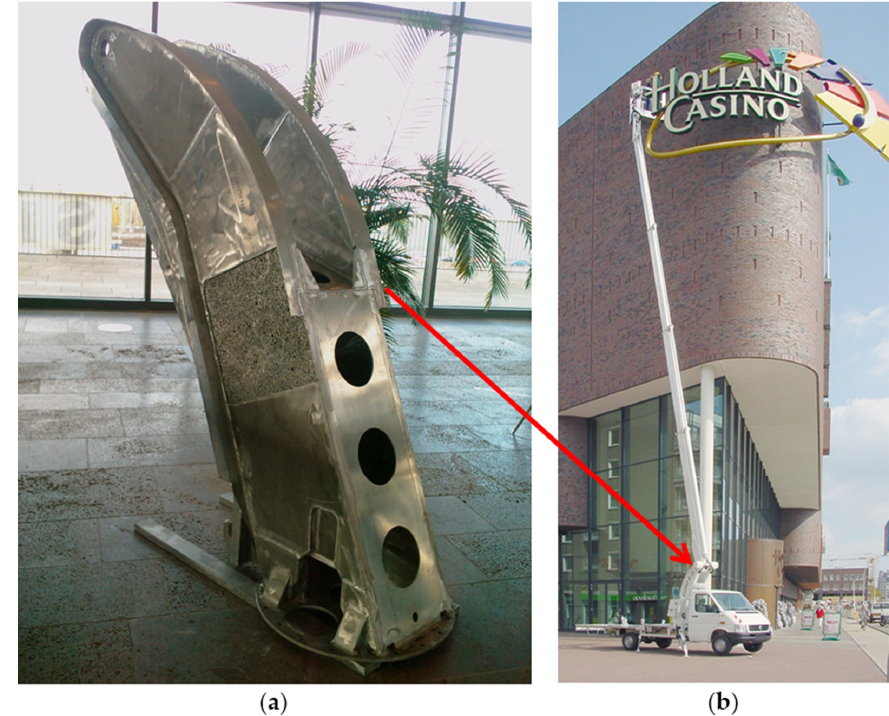
and ( b ) mobile crane vehicle from Teupen (Gronau, Germany) where the support is applied (courtesy of Pohltec Metalfoam).